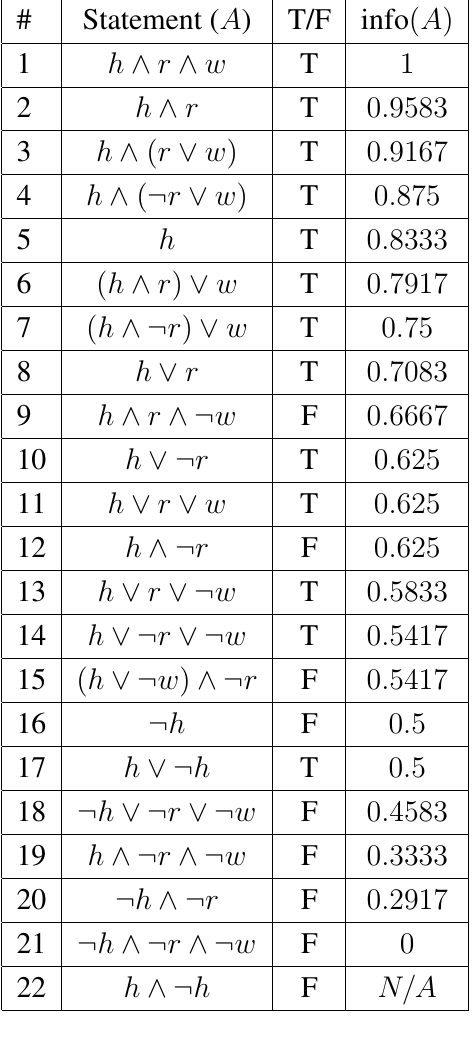
Table 10. Information yield results using the value aggregate